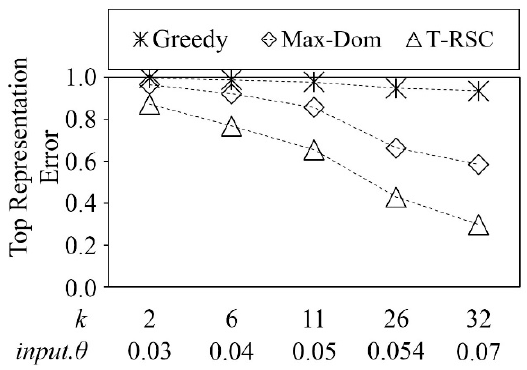
Figure 15. Comparison of top representation error on NBA dataset.